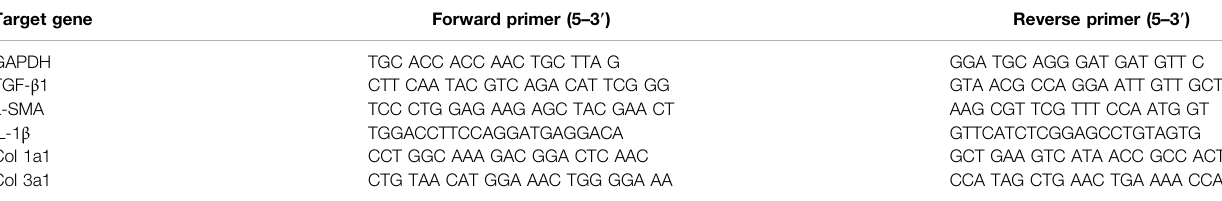
TABLE 1 | PCR primer sequences. Target gene Forward primer (5 – 3 9 )